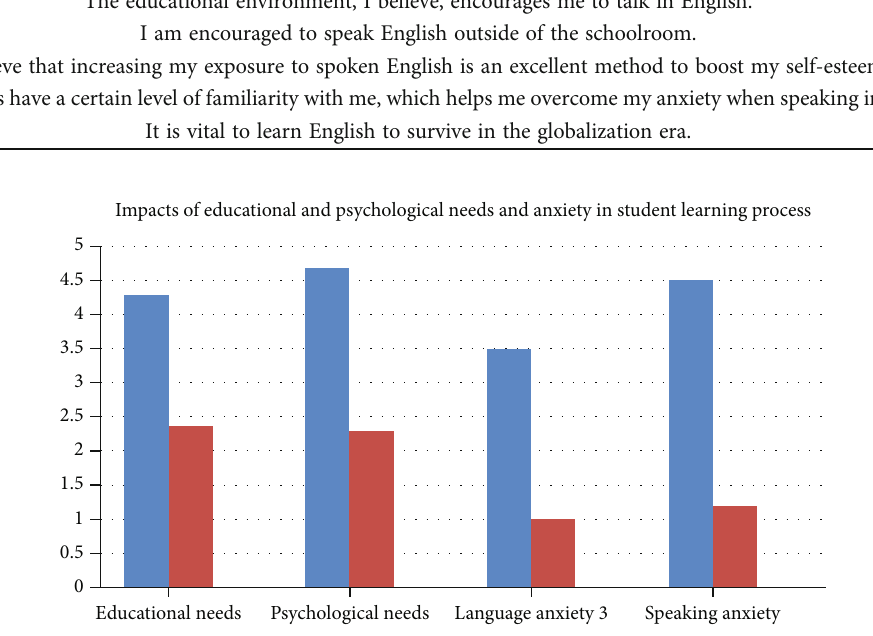
Figure 2: The overall percentage of educational, psychological needs, and anxiety in their learning process.